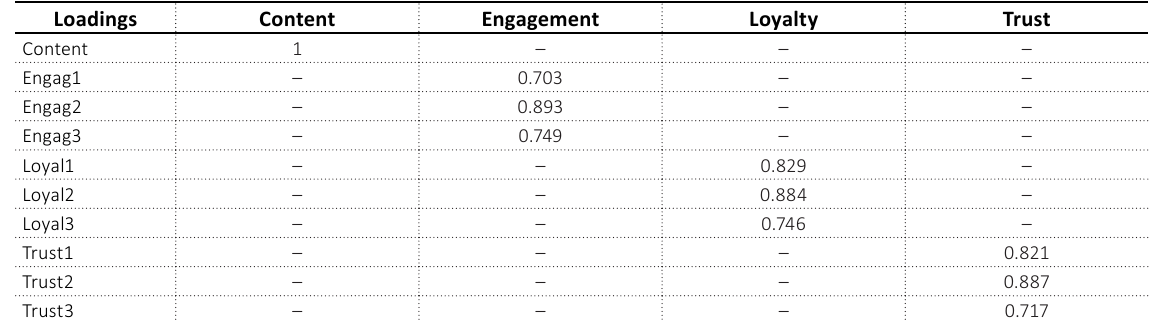
Table 3b. Outer model loadings